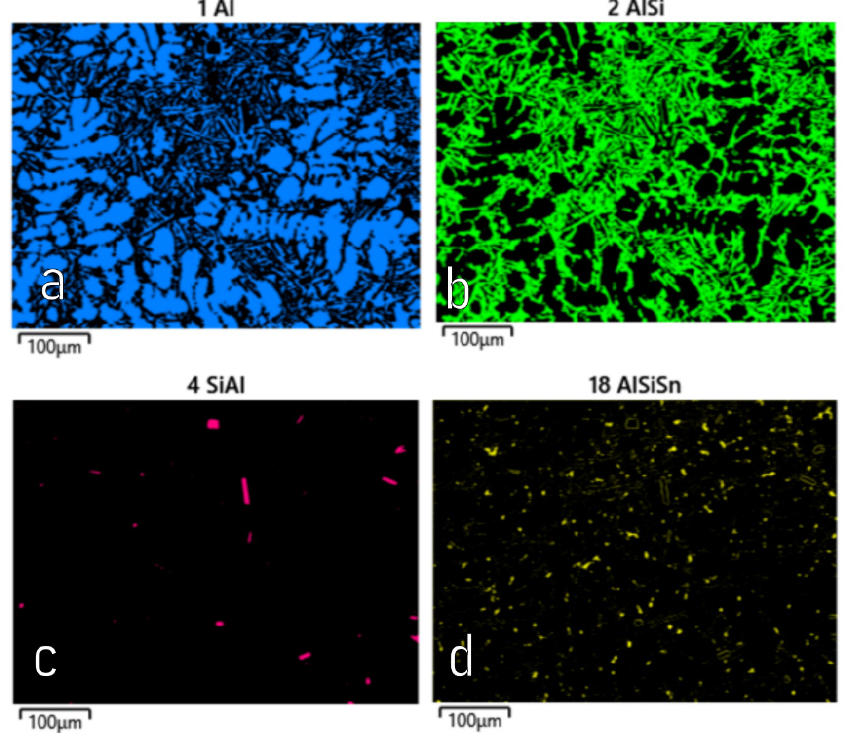
Figure 21. Phase distribution maps for AlSi10Sn1.7: ( a ) Al; ( b ) AlSi; ( c ) SiAl; ( d ) AlSiSn.